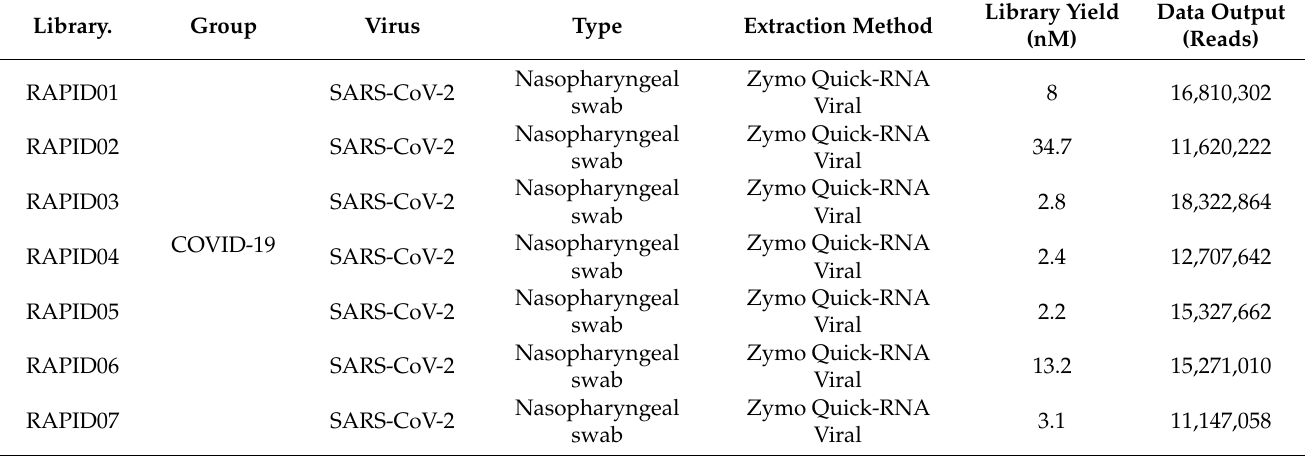
Table 3. RAPID prep sample summary overview